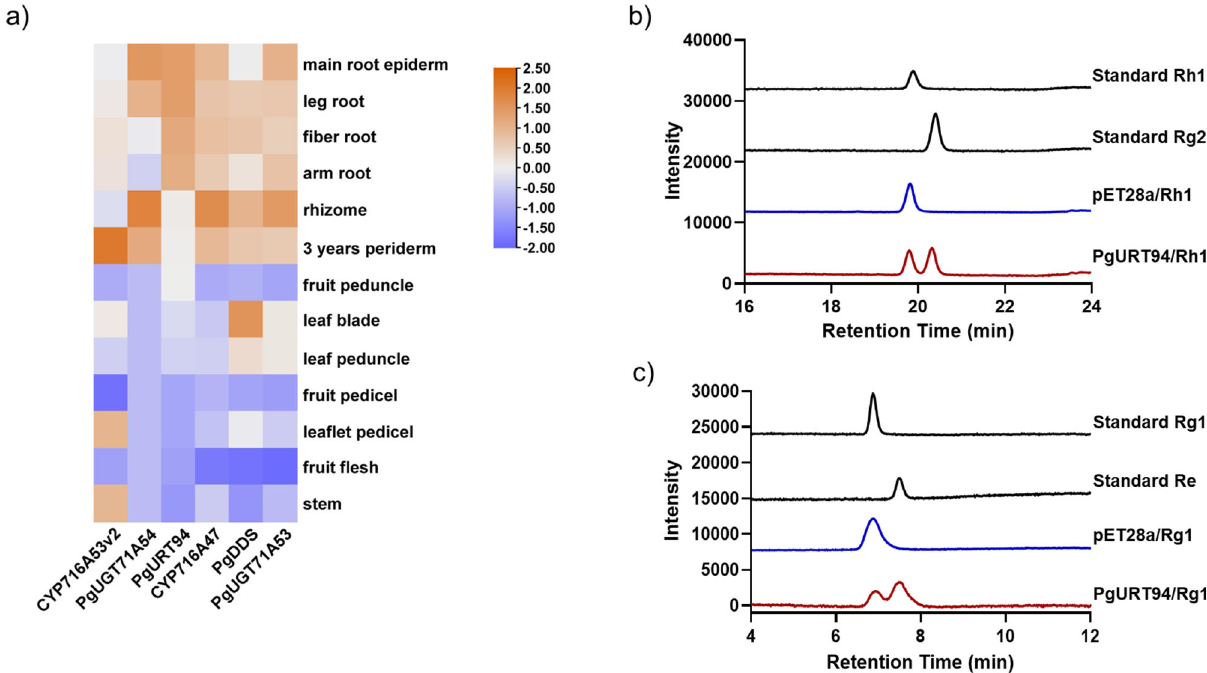
Fig. 2 Expression pattern analysis of PgURT94 and its enzymatic activity toward Rh1 and Rg1 as substrates. a Heat-map analysis of the relative abundance of PgURT94 expression, along with PgDDS , CYP716A47 , CYP716A53v2 , and PgUGT71A53 in different parts of P. ginseng . b HPLC analysis of the in vitro reaction products catalyzed by PgURT94 crude enzyme using Rh1 as sugar acceptor and UDP-rhamnose as sugar donor. c HPLC analysis of the in vitro reaction products catalyzed by PgURT94 crude enzyme using Rg1 as sugar acceptor and UDP-rhamnose as sugar donor. Crude enzymes of E. coli strain harboring pET28a empty vector were used as a negative control for above assays and authentic ginsenoside samples Rh1, Rg1, Rg1, and Re were monitored as standards.